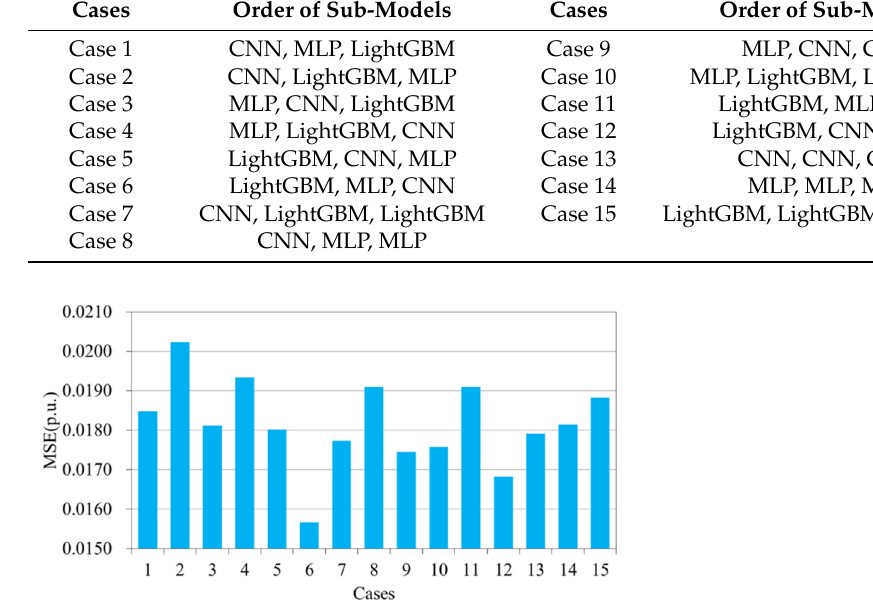
Table 2. The different cases.